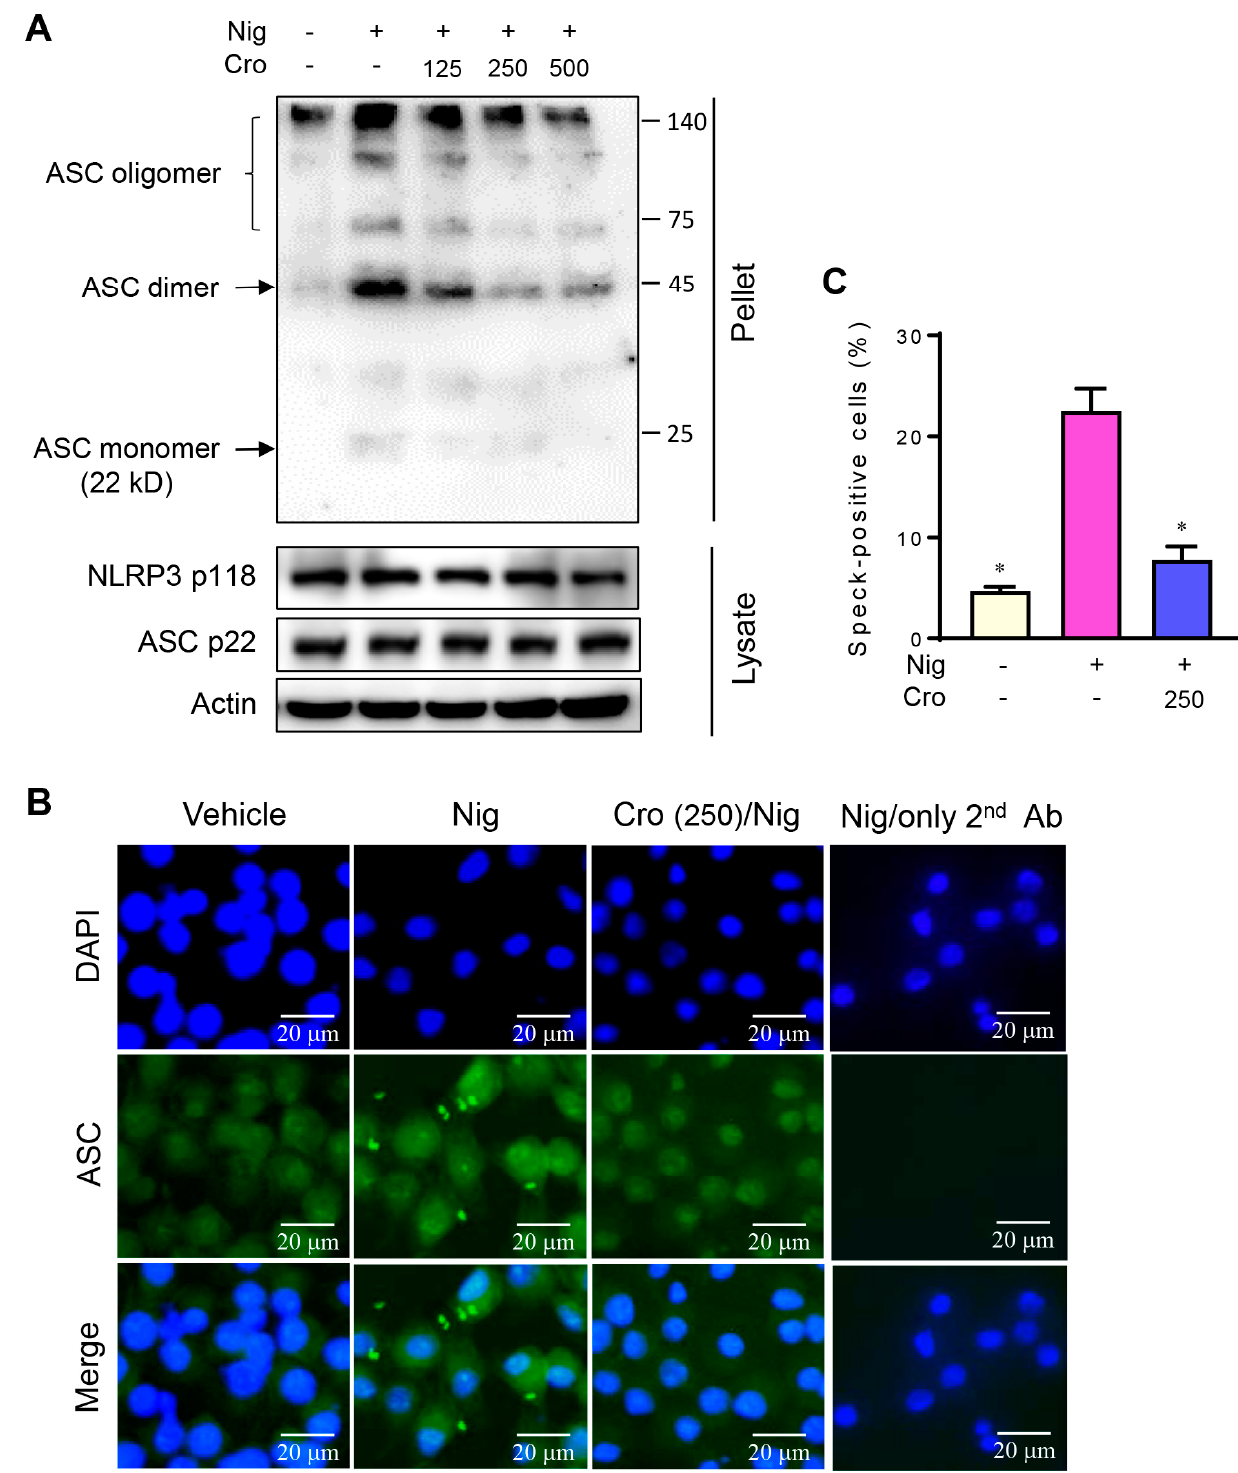
Figure 5. Effects of Crocin on ASC oligomerization and ASC speck formation. LPS-primed J774A.1 cells were pretreated with various concentrations of Crocin for 3 h, and then incubated with Nigericin (4 µ M) for 1 h. ( A ) DSS-crosslinked ASC in the NP-40-insoluble pellet was analyzed by Western blot. ( B ) Evidence of ASC specks by fluorescence microscopy. The last column shows a negative control represented by secondary antibody treatment alone. Bars indicate 20 µ m. ( C ) Quantification of ASC specks. The data are expressed as the mean ± SEM and represent three experiments. * p < 0.05 vs. group treated with Nigericin.